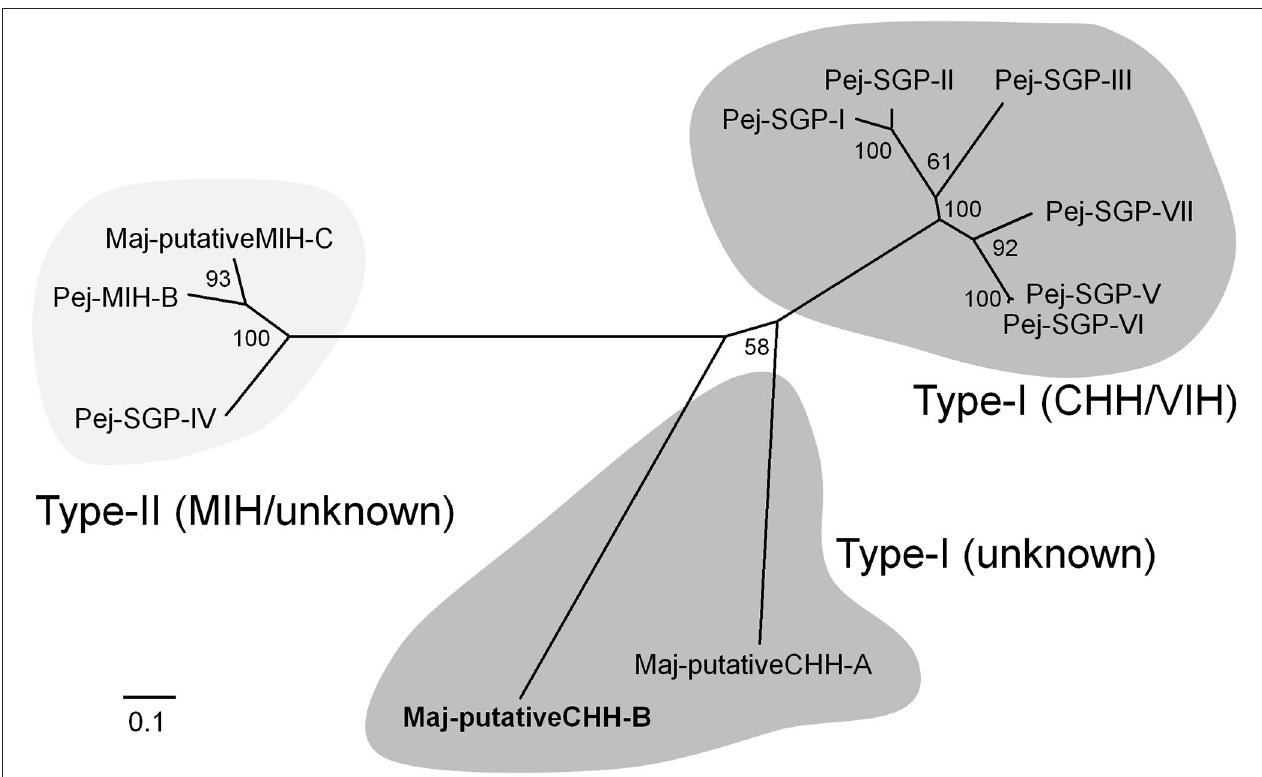
FIGURE 2 | Molecular phylogenetic tree of M. japonicus CHH-family peptides. This phylogenetic tree was constructed by the neighbor-joining method with computation of the evolutionary distances using the JTT matrix-based method. Values at the nodes represent the percentage of 1,000 bootstrap replicates. The scale bar shows the number of substitutions per site. Amino acid sequences have been cited from the previous reports (25, 26, 67).